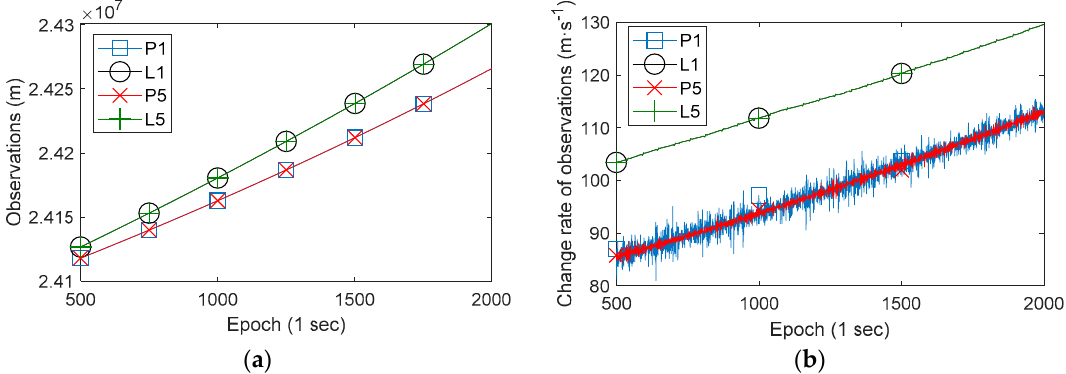
Figure 4. The observations (Galileo 03 satellite) and its change rate of a Xiaomi MI 8 smartphone. ( a ) The raw observations; ( b ) The change rate of observations.